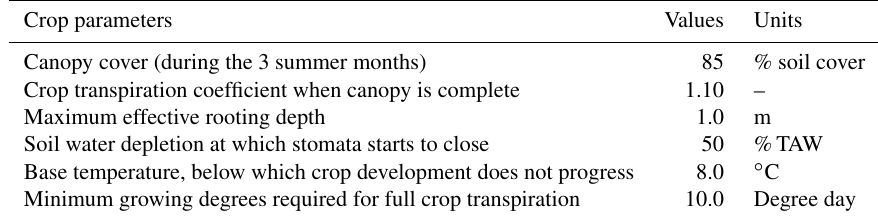
Table 1. Characteristics of the representative field crop. Crop parameters Values Units Canopy cover (during the 3 summer months) 85 % soil cover Crop transpiration coefficient when canopy is complete 1.10 – Maximum effective rooting depth 1.0 m Soil water depletion at which stomata starts to close 50 %TAW Base temperature, below which crop development does not progress 8.0 ◦ C Minimum growing degrees required for full crop transpiration 10.0 Degree